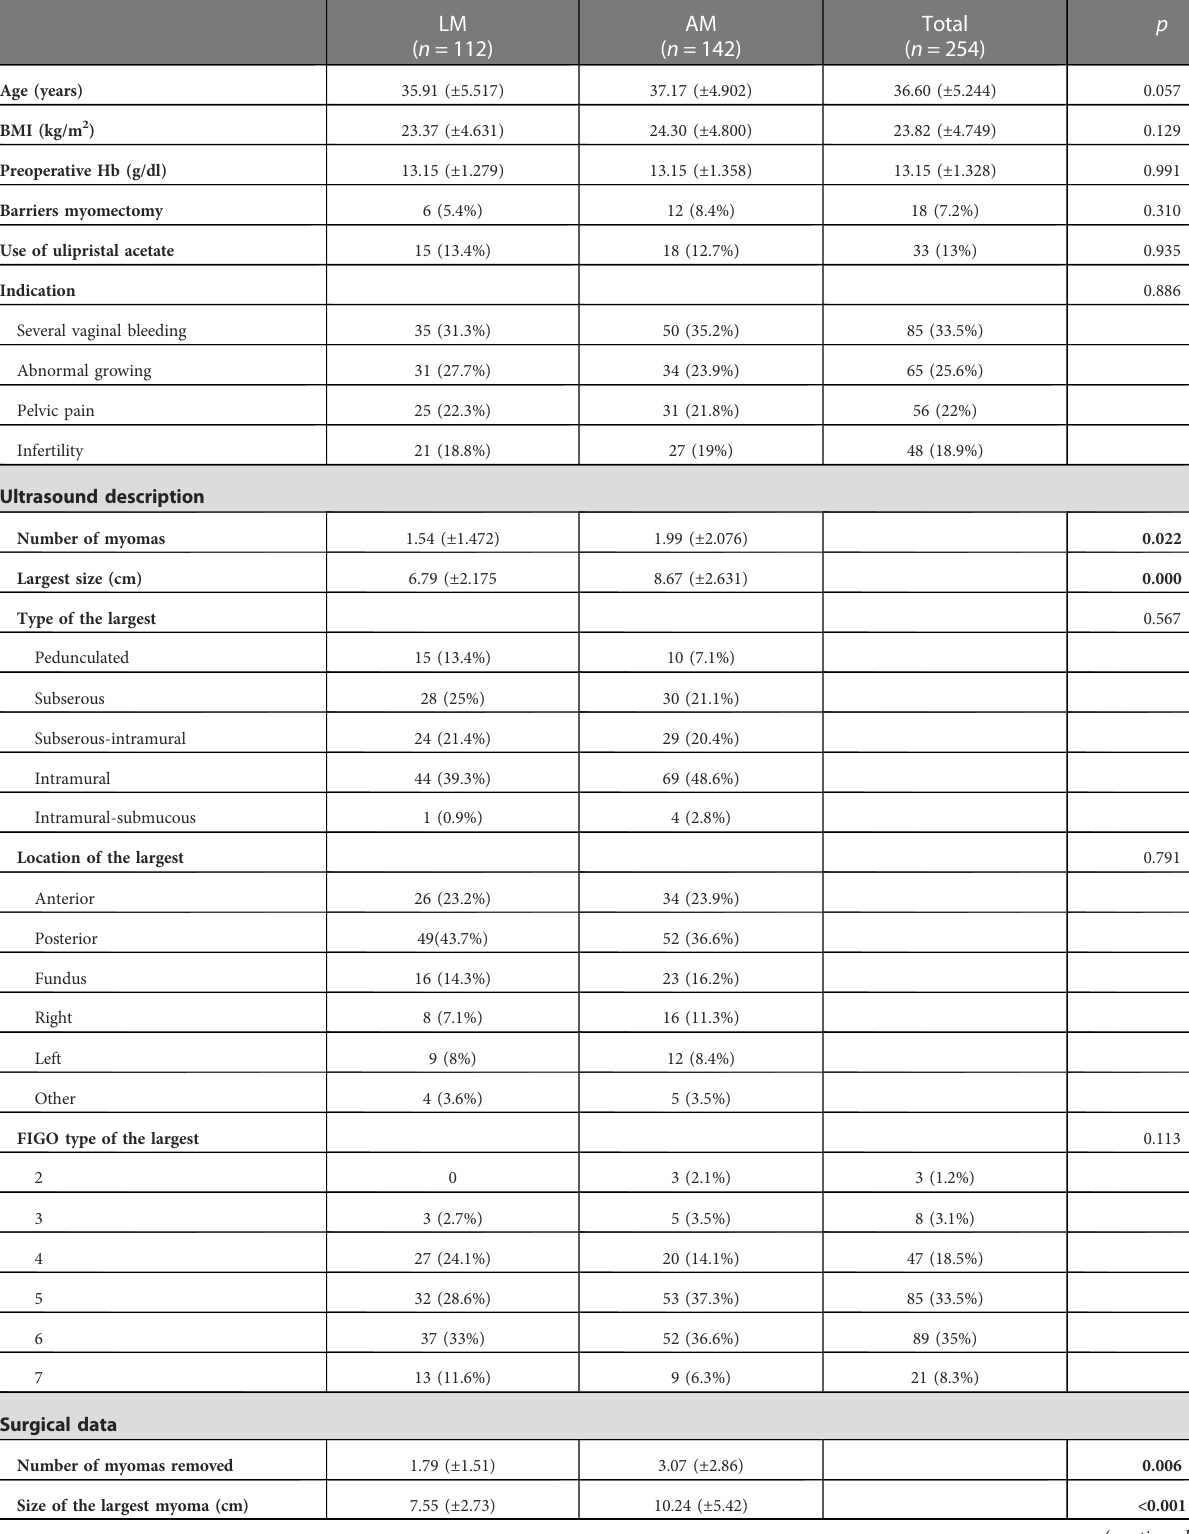
TABLE 1 Patient characteristics of the two groups (laparoscopic myomectomy versus abdominal